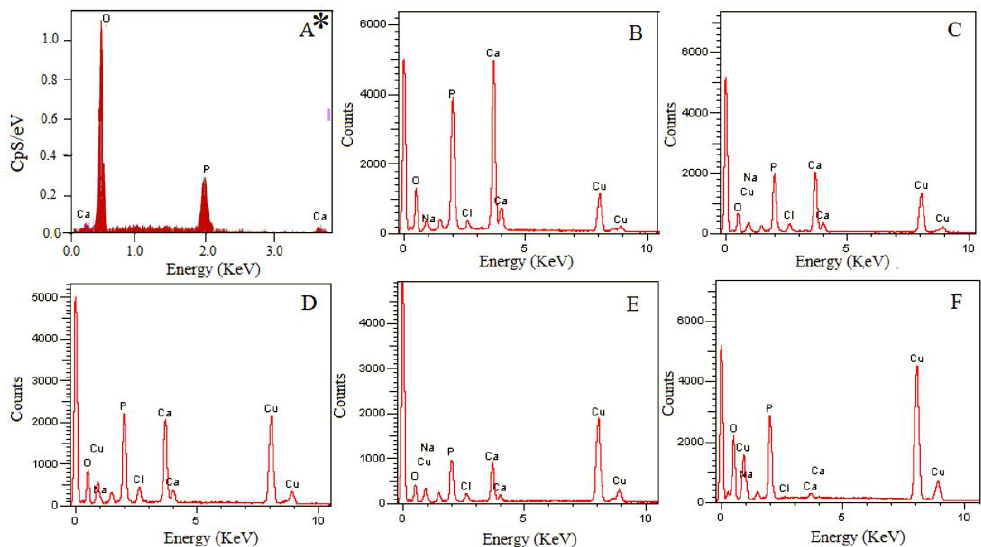
Figure 5. EDX analysis of ( A ) BCu0, ( B ) BCu2, ( C ) BCu4, ( D ) BCu5, ( E ) BCu6, and ( F ) BCu10 compounds. * Different scale of measurements. Table 4. Chemical composition of the Ca-Cu compounds in atomic% based on the EDX analysis (Figure 5).